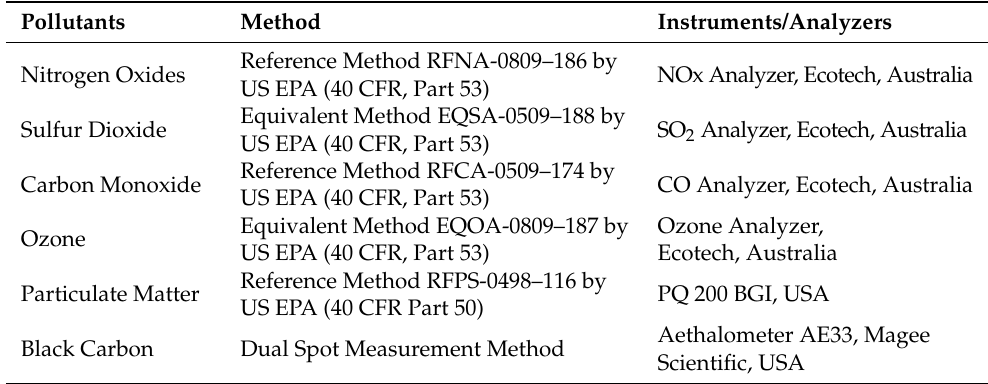
Table 1. Ambient air quality and monitoring methods